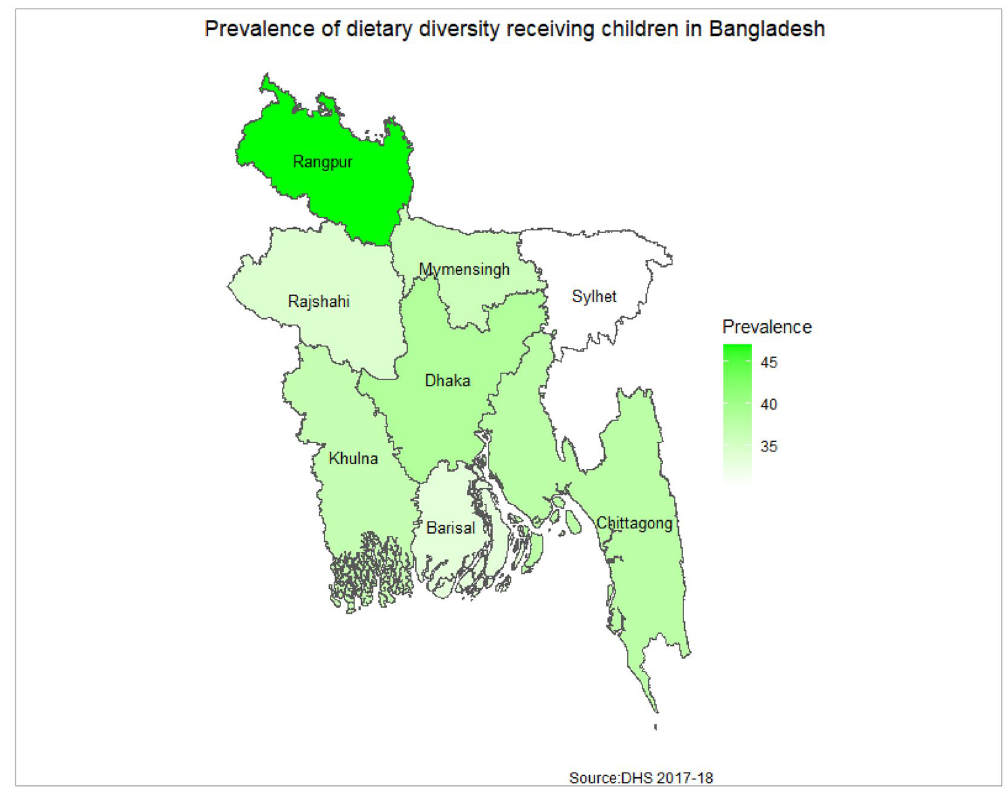
Figure 2. Distribution of minimum dietary diversity across eight divisions of Bangladesh. The map was created using R version 4.2.1 (https:// cran.r- proje ct.